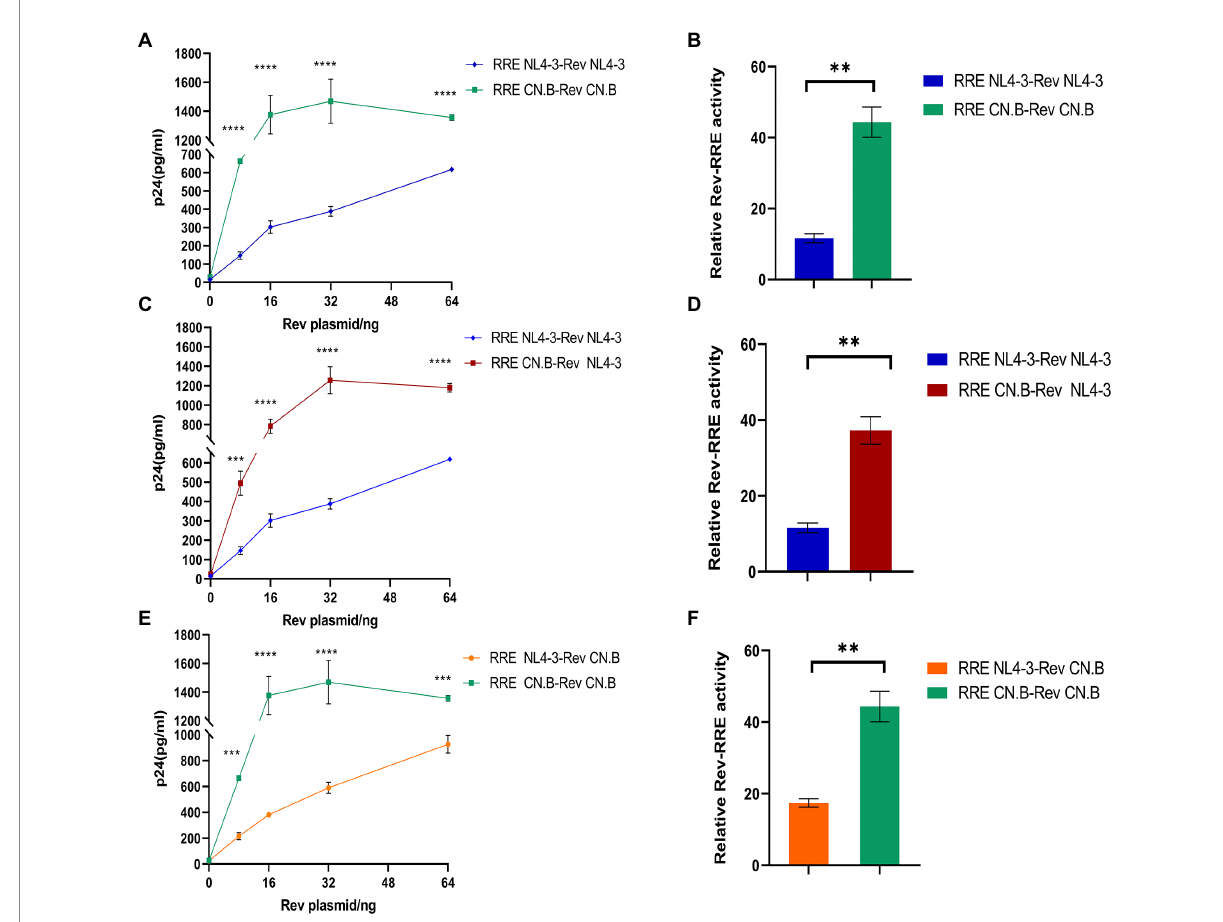
FIGURE 6 Influence of RRE subtype characteristics on functional activity of Rev-RRE. (A,C,E) The concentrations of p24 expressed by the reporter gene changed with the changes of Rev expression plasmid concentration when the two subtypes Rev were combined with the two subtypes RRE, respectively. (B,D,F) The difference in relative activity of Rev combined with RRE under corresponding conditions. Each experiment was repeated twice, and bars show the standard error of the mean from two replicates. * p < 0.05, ** p < 0.01, *** p < 0.001, and **** p <